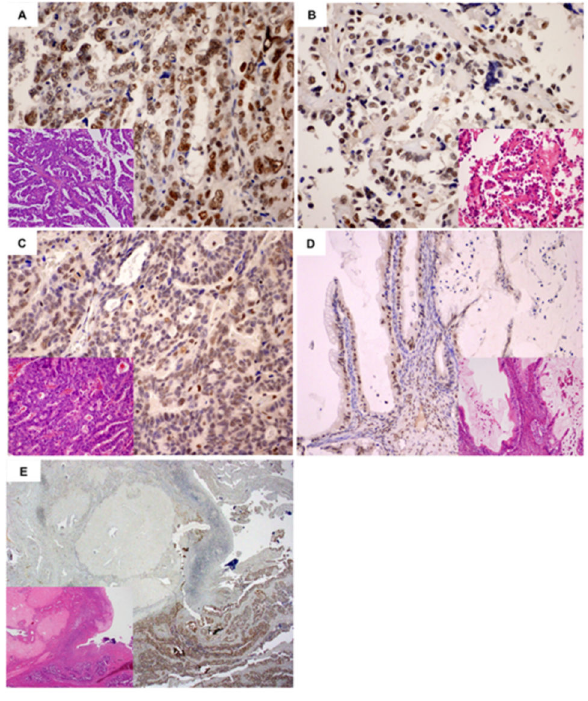
Table 2. Scored Immunohistochemical RECQL1 Expression and Relationship to Histologic Type and FIGO Stage.